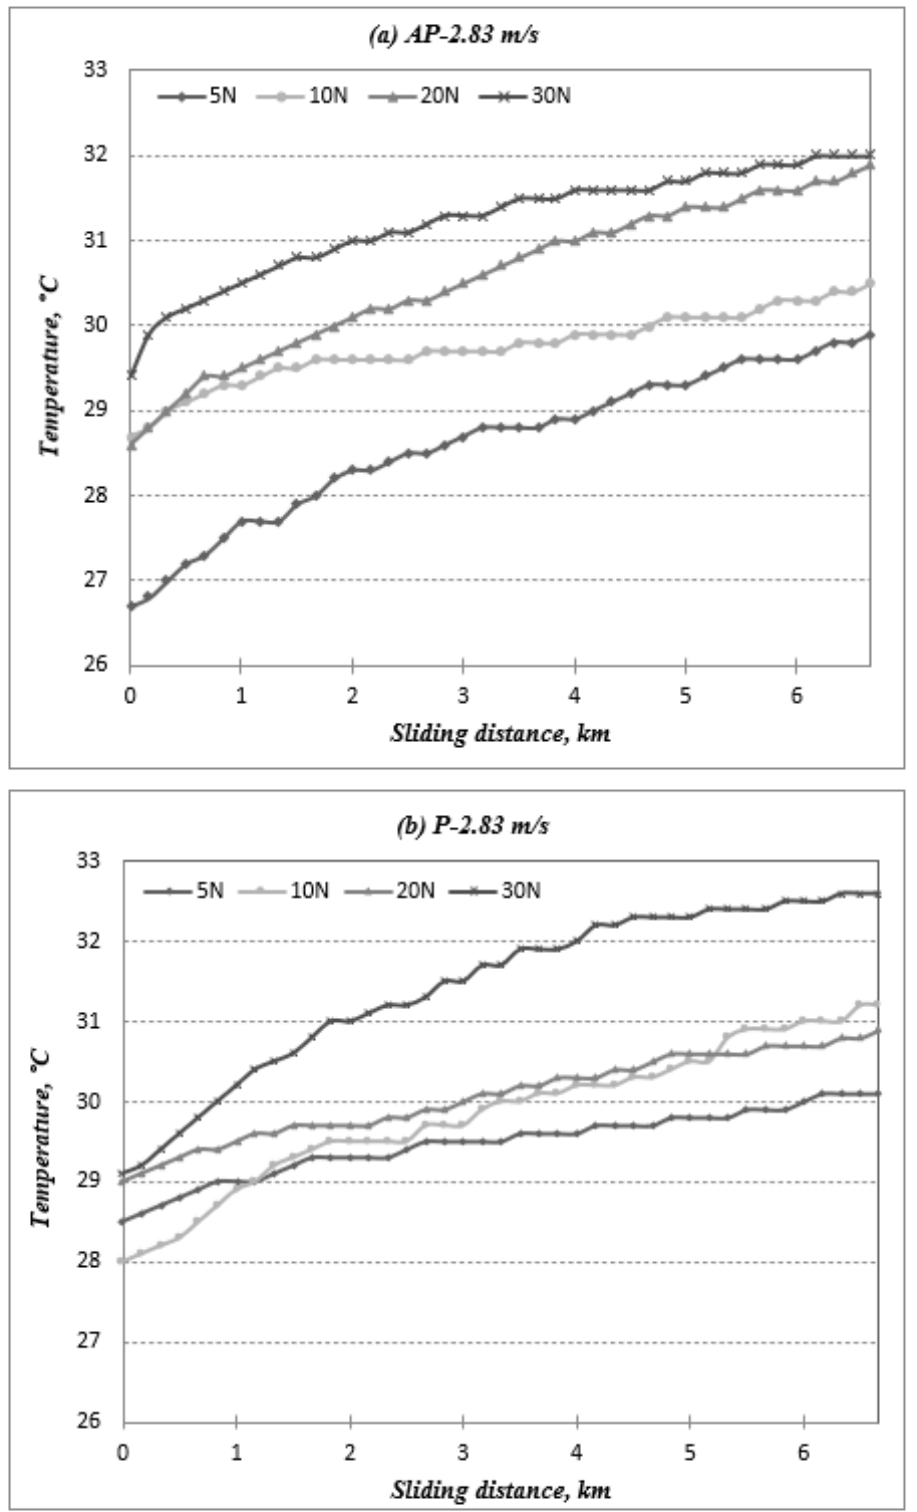
Figure A5. Temperature vs. sliding distance for AP and P fibre orientation subjected to different applied normal loads at 2.83 m/s counterface sliding velocity .